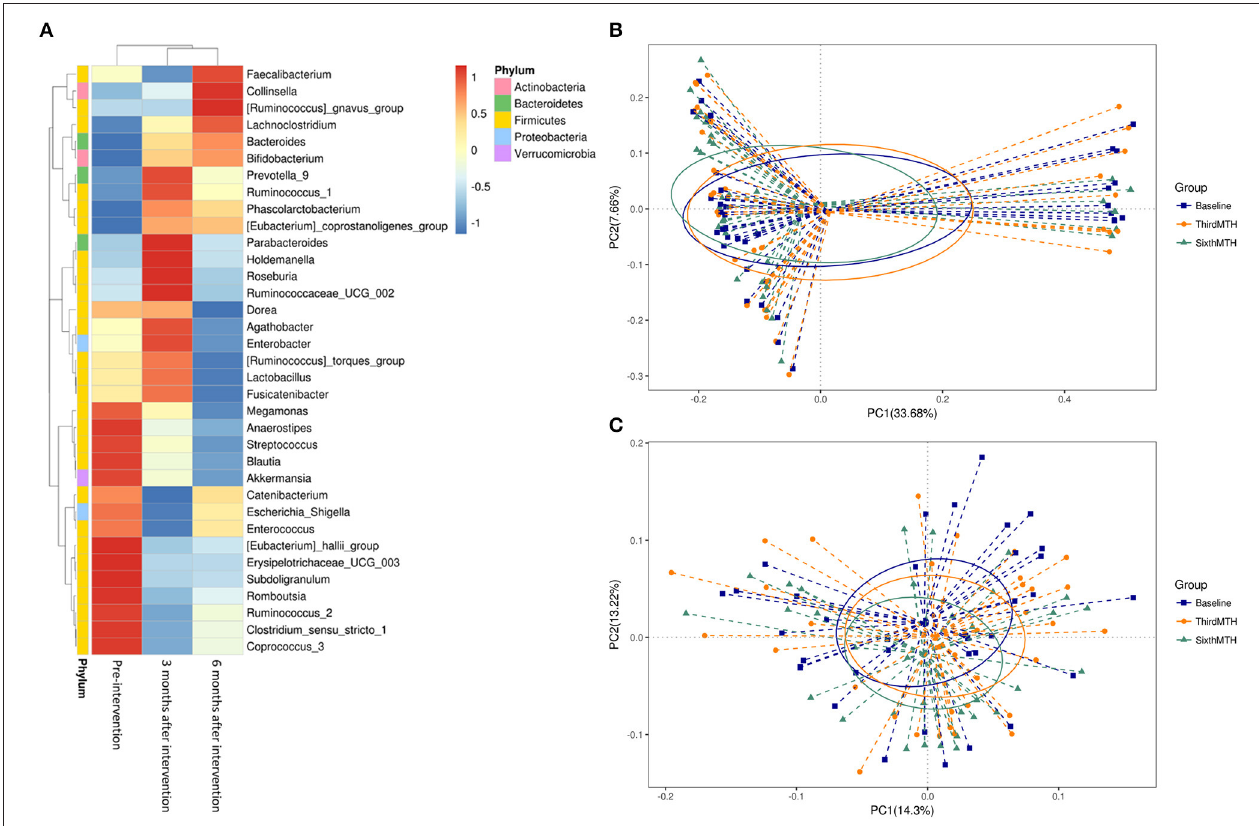
FIGURE 5 | (A) Taxonomic composition of the genus level at pre-intervention and 3 and 6 months after intervention in the patients with CKD. Principal coordinates analysis (PCoA) plot. (B) unweighted UniFrac, (C) weighted UniFrac at pre-intervention and 3 and 6 months after intervention in the patients with CKD.